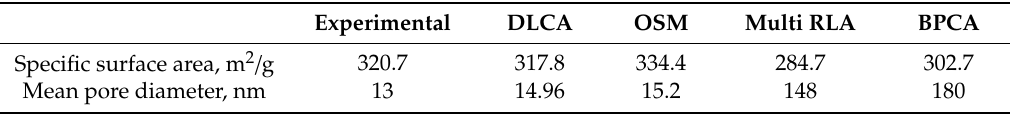
Table 1. Comparison of measured and calculated structural properties.